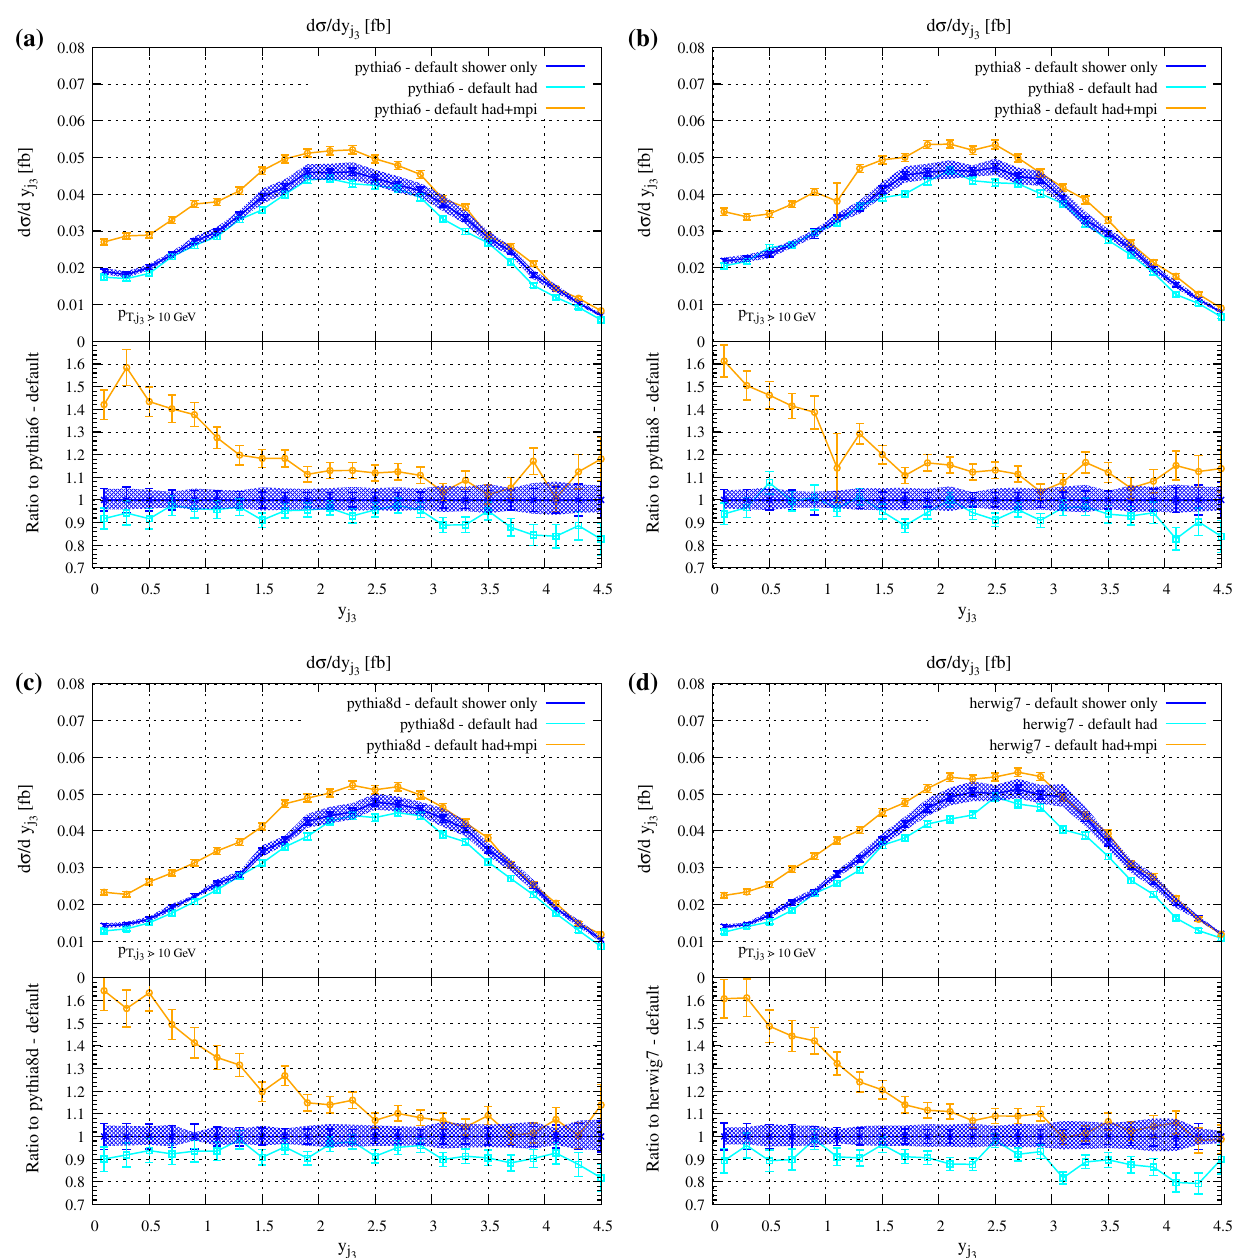
Fig. 5 Rapidity distribution of the third jet in the CMS-tight sce- nario for different SMC settings [blue: parton shower only, cyan: par- ton shower with hadronization, orange: parton shower with hadroniza- tion and multi-parton interactions]. The same observable is shown for PYTHIA6 ( a ), PYTHIA8 withrecoilshower( b ), PYTHIA8 withdipole